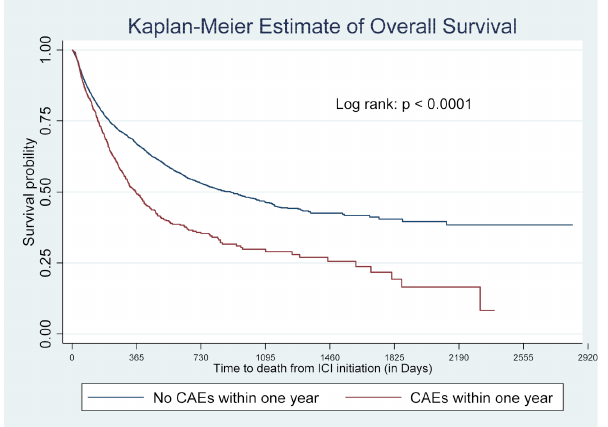
Figure 3. Kaplan–Meier estimate of overall survival. CAE: cardiac adverse event. ICI: immune checkpoint